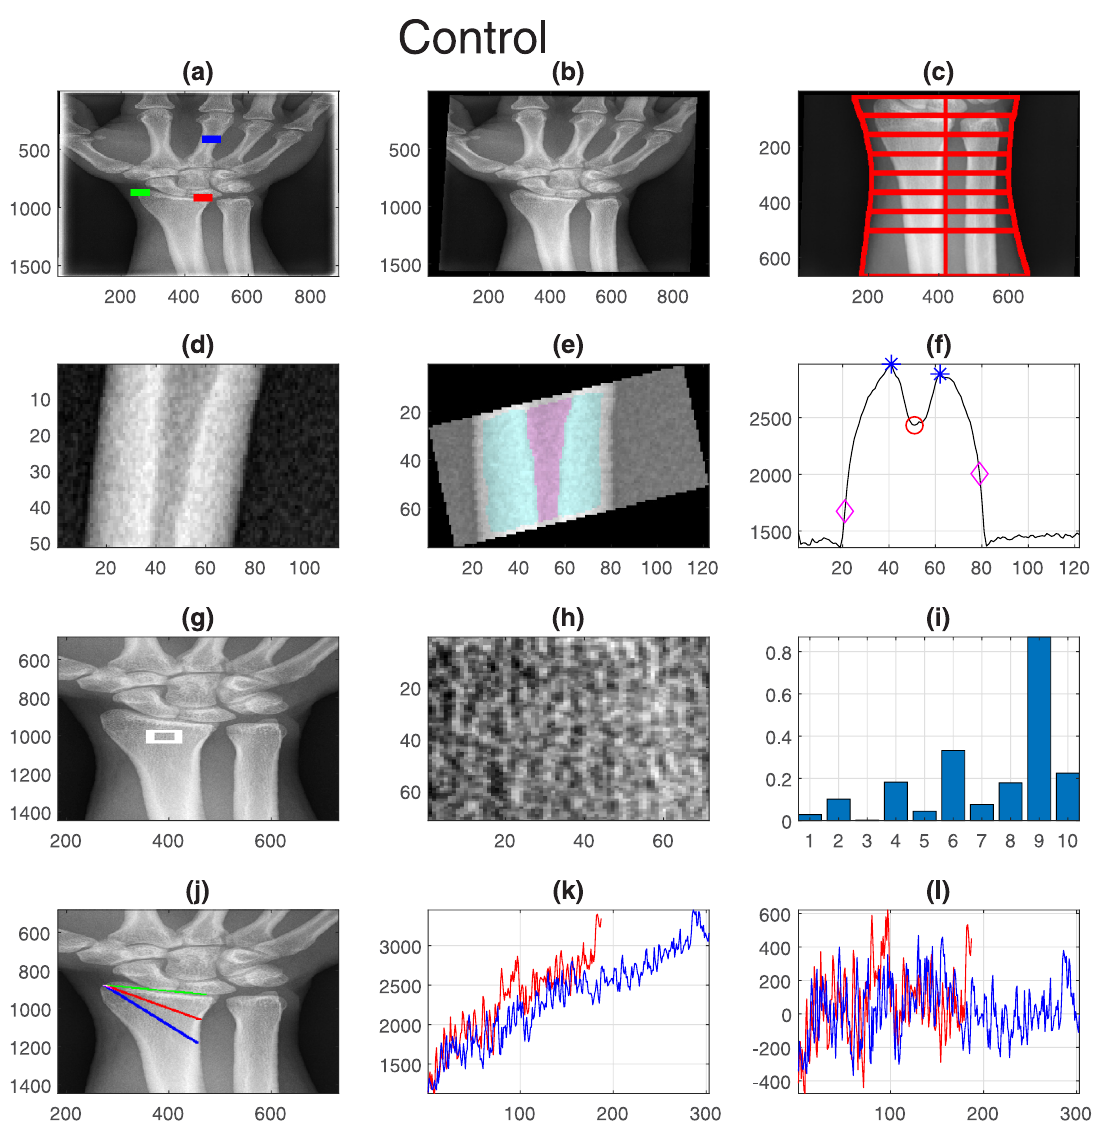
Fig 15. Control: One representative case with all its measurements. Refer to Fig 11 for the